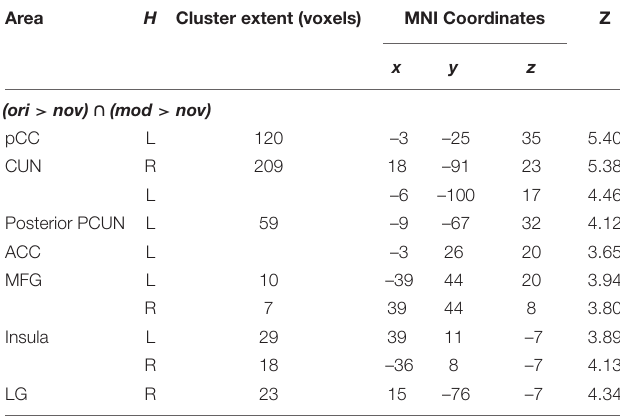
TABLE 1 | Peak activations from second-level whole-brain analyses of episodic